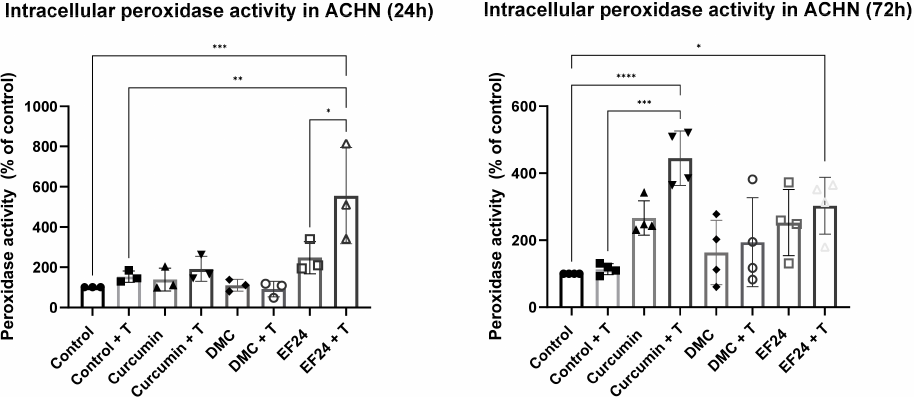
Figure 5. The level of intracellular peroxidase was increased in ACHN after 24 h treatment with Curcumin + TRAIL, EF24 and EF24 + TRAIL. However, the increase was only significant after treatment with EF24 in combination with TRAIL (555.51%). After 72 h, intracellular peroxidase was significantly increased after treatment with Curcumin + TRAIL (535.84%) and EF24 + TRAIL (302.52%). All samples were normalized to protein concentration and to vehicle control. 24 h n = 3; 72 h n = 4. * p < 0.05, ** p < 0.01, *** p < 0.001, **** p <